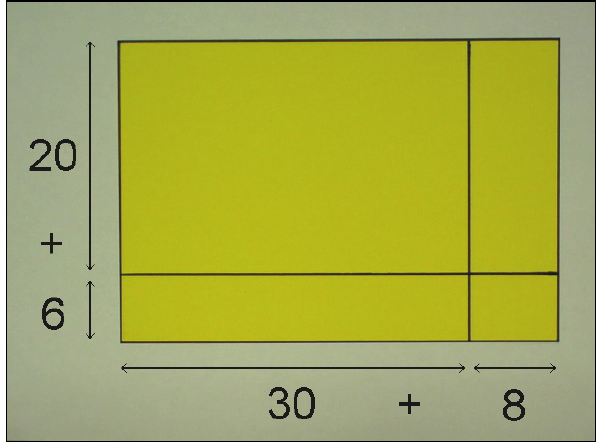
Figure 1 : Frame 25 from the video clip “rectangular products”